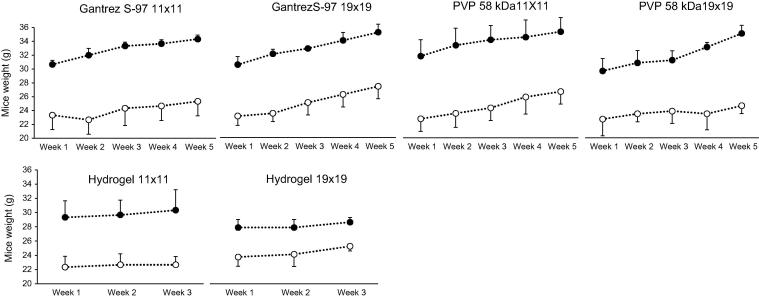
Graphs display the recorded weights of the mice over the entire experimental period. Each graph represents one MN-treated group with a particular formulation and needle configuration. Female -○- and male -●- values were plotted separately (Means ± S.D.; n = 3).